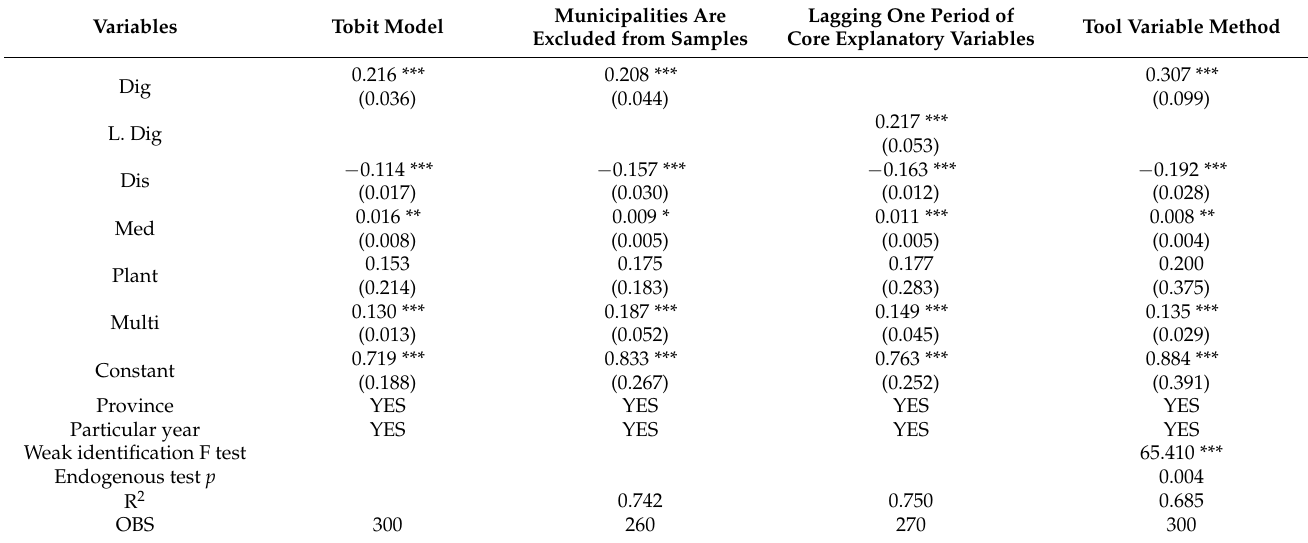
Table 5. Robustness